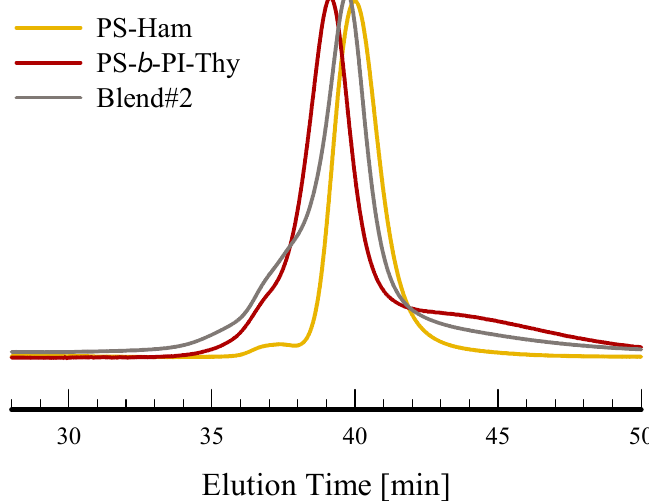
Figure 12. SEC traces of the samples PS ‐ Ham, PS ‐ b ‐ PI ‐ Thy, and Blend #2.